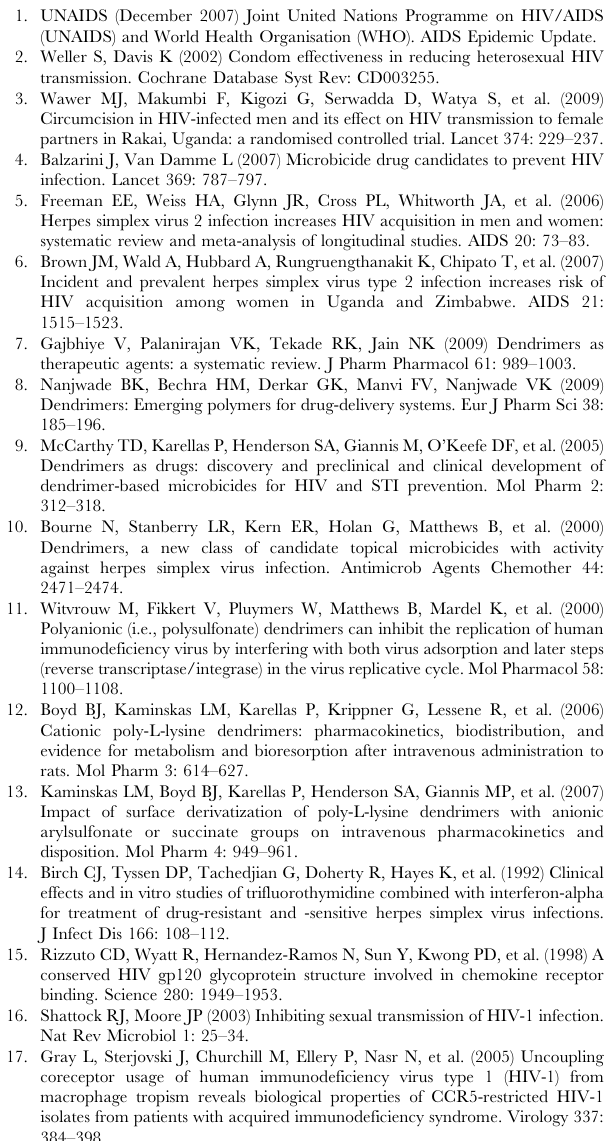
Table S3 SPL7013 is active against HIV-2 in PBMCs.